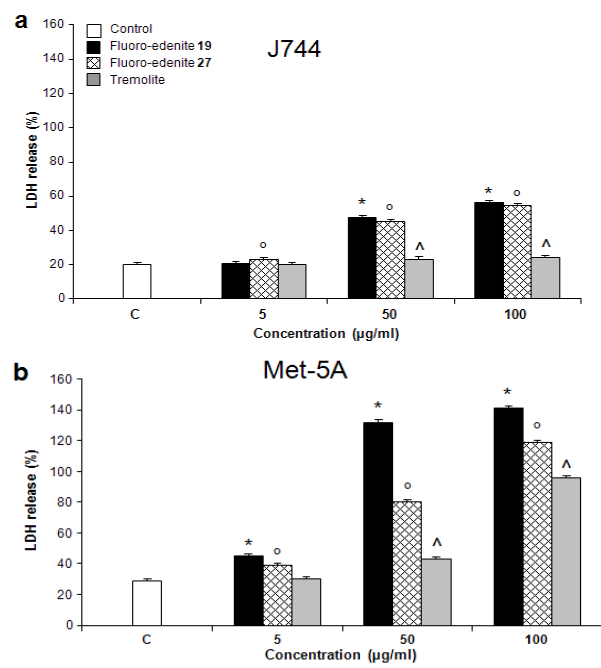
Figure 4: Detection of lactate dehydrogenase (LDH) release from J774 (a) and Met-5A (b) cells expressed as percentage of LDH released into the culture media with respect to total LDH. The values are the mean ± SEM of three experiments performed in triplicate. All values with P<0.01 were considered significantly different. The symbols *°^ represent significantly different values versus untreated control.